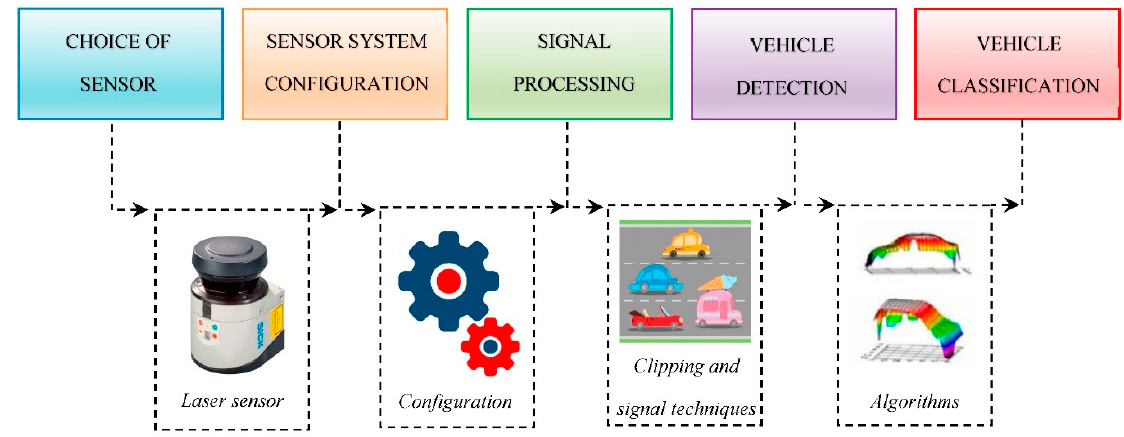
Figure 3. Procedure to configure a laser system correctly.